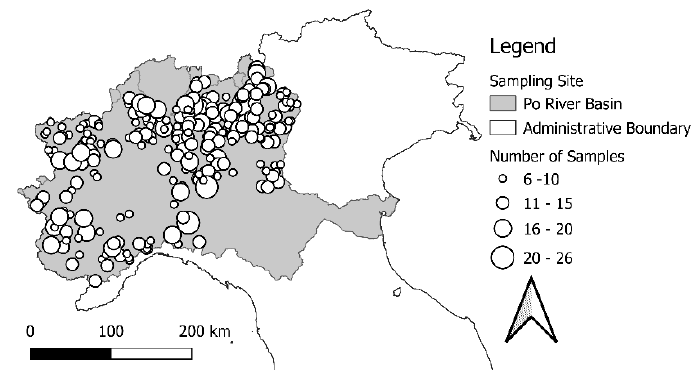
Figure 1. Map of the study area with the location of sampling sites.